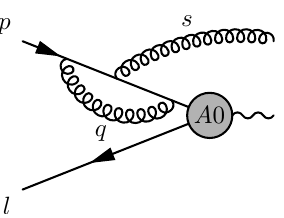
Figure 2 . Example of a LP diagram with a collinear loop and a LP soft emission. This diagram is